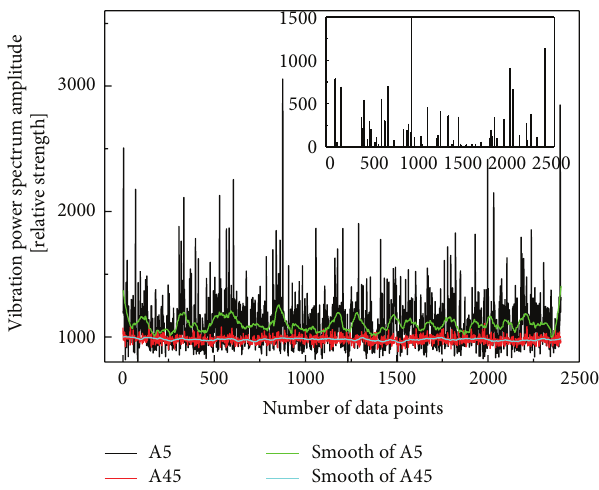
Figure 3: Comparisons of the power spectrum of number A5 well and number A45 well.